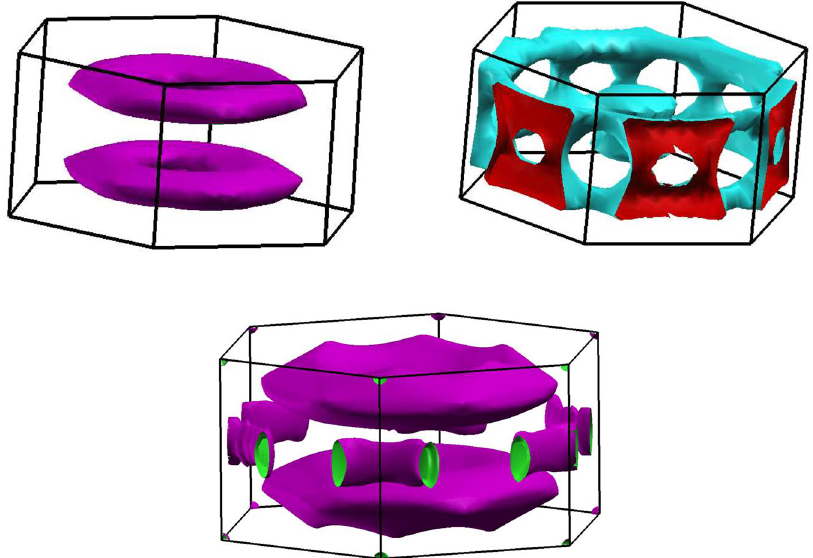
Figure 3. The calculated Fermi surfaces for hexagonal non-magnetic FeS - band 20, top left; band 21, top right. The bottom plot shows the FeS band 20 isoenergy surface for a Fermi level taken approximately 70 meV below the actual Fermi level. Brillouin zones are rotated slightly to better depict the Fermi surfaces. Note the predominant 1-dimensional character of band 20, the more three dimensional character of band 21, and the much larger band 20 isoenergy surface in the bottom plot, indicative of the nearness to the van Hove singularity.